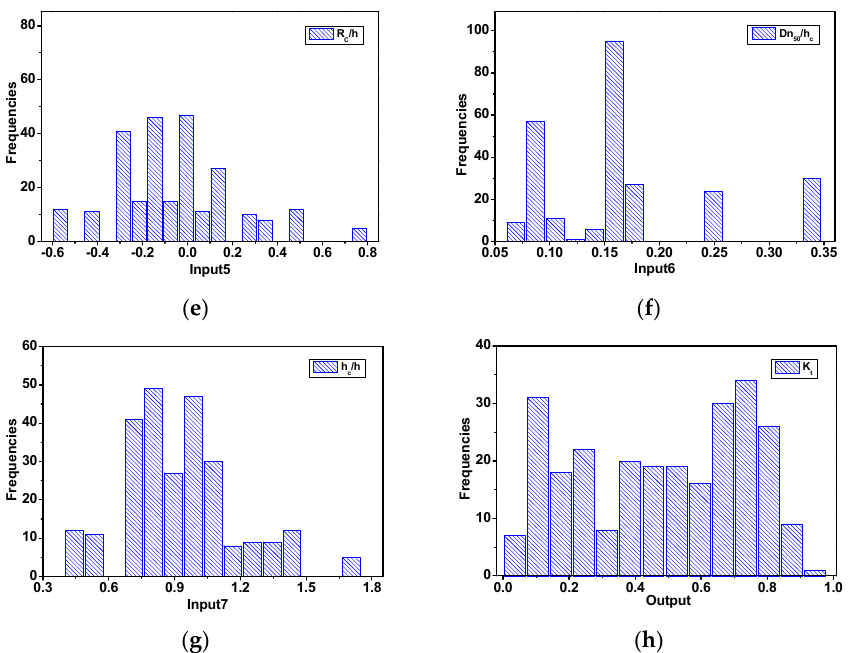
Figure 2. Results and discussion. ( a ): R C /H 0; ( b ): B/H 0; ( c ): ξ ; ( d ): B/L 0; ( e ): R C /h; ( f ): Dn 50 /h c ; ( g ): h c /h; ( h ): K t .